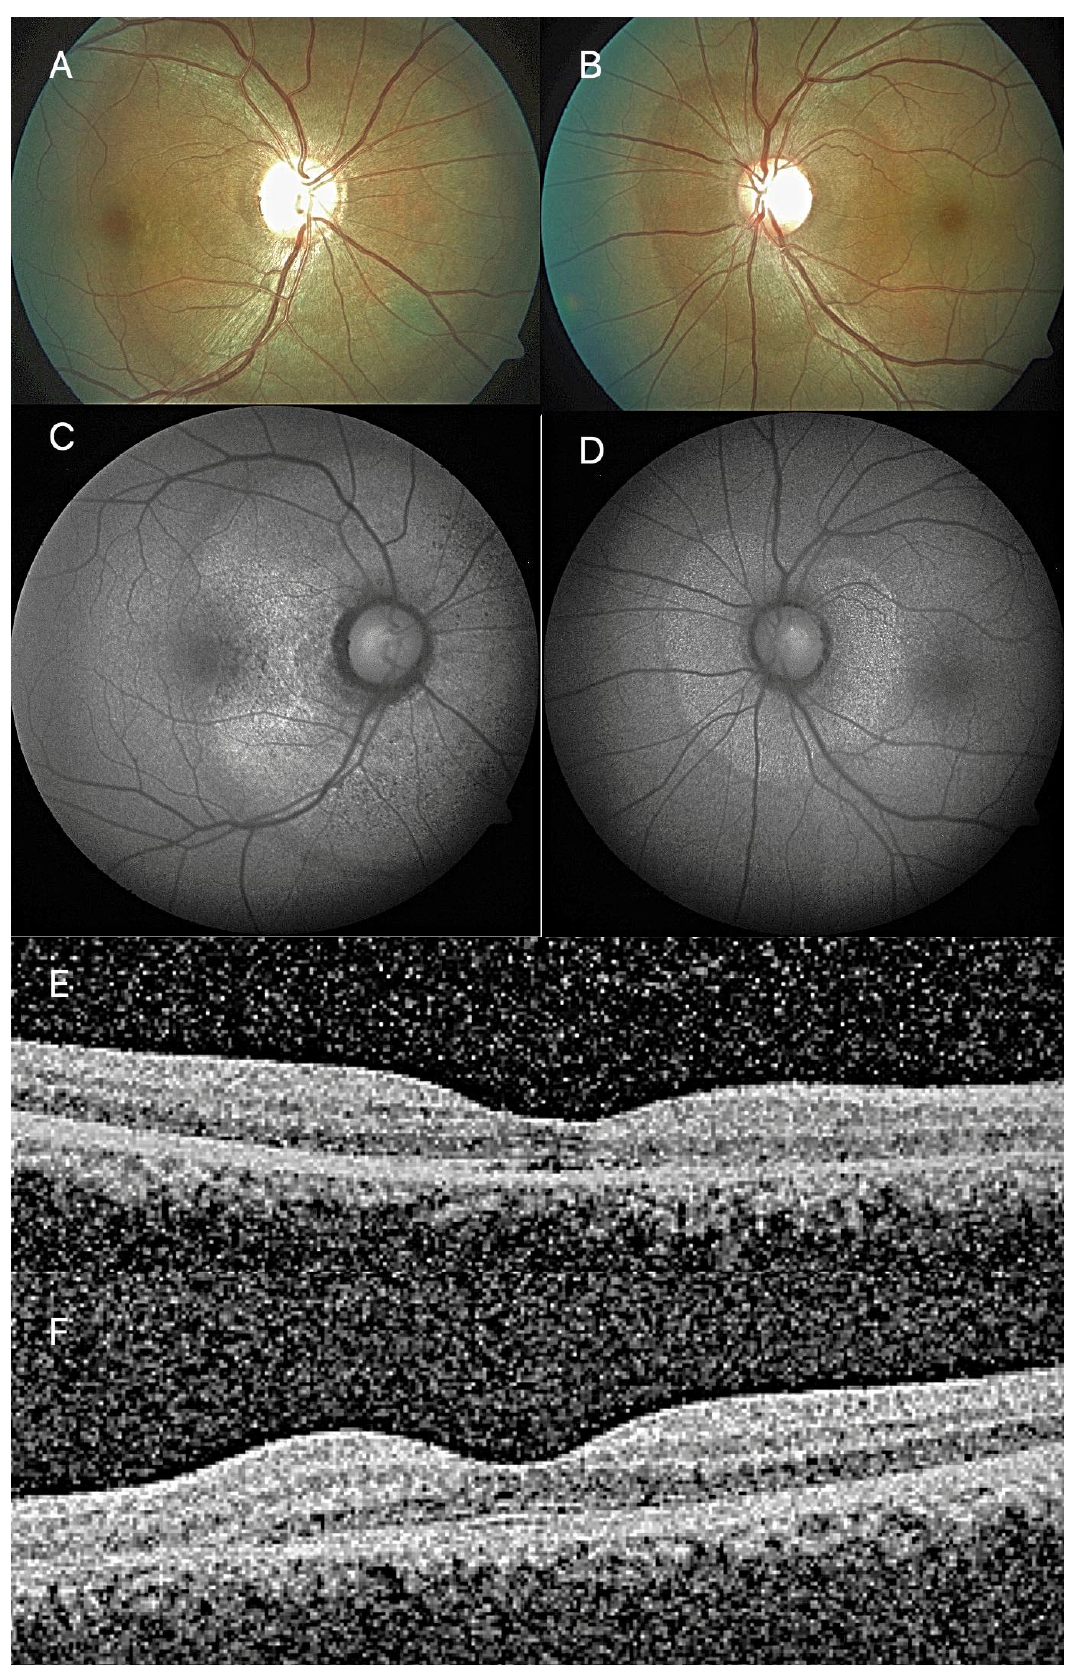
Figure 2: At 3-month follow-up, fundus reveals persistent AZOOR lesions with a marginal opacification in both eyes; right (A) larger than left (B). FAF imaging reveals a progressive hypo-autofluorescence at the margins (C, D). OCT scan of the right (E) and left (F) eye shows no